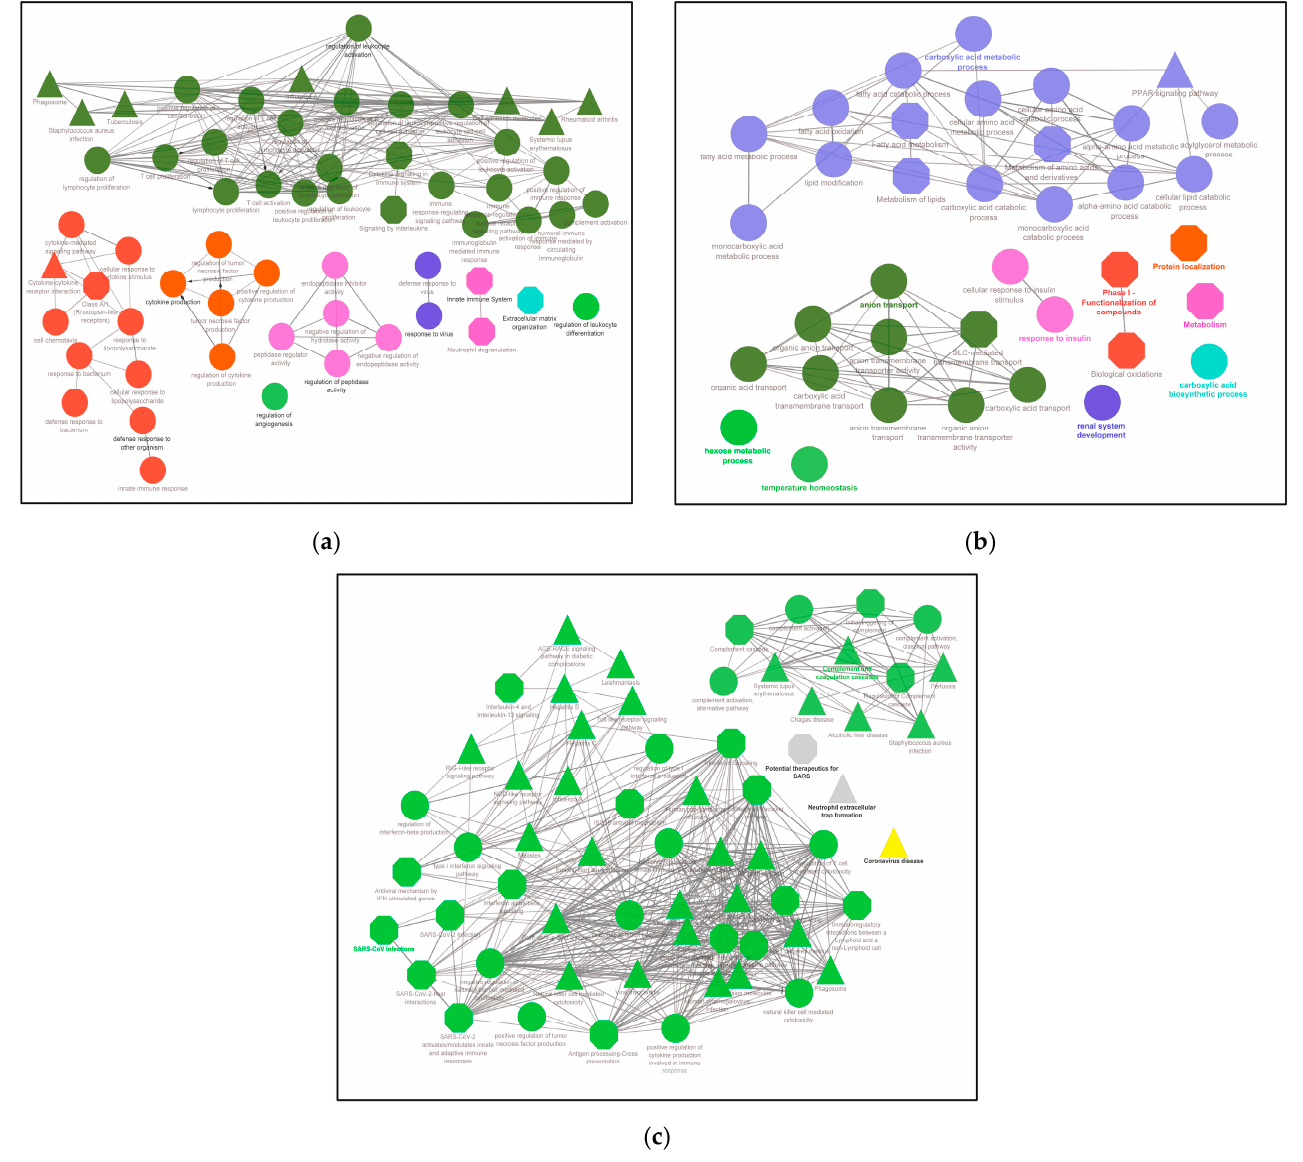
Figure 6. Network analysis of the functional role of deregulated genes in diabetic kidney disease. ( a ) Inter-relational pathway enrichment analysis is shown for the upregulated DEGs in DKD samples; ( b ) for the downregulated DEGs in DKD; ( c ) for the 41 DEGs overlapping DKD and COVID-19 pathways. Circle represents GO terms, triangle and octagon represent KEGG and REACTOME, respectively, while green, orange, purple and pink color represent pathways.